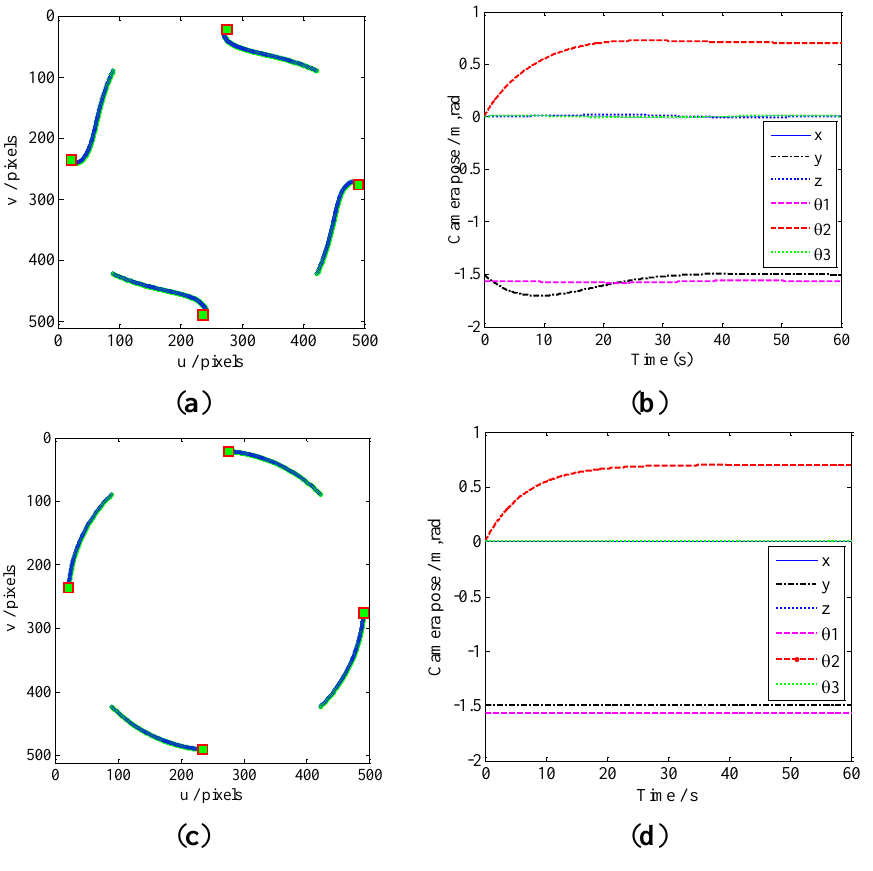
Figure 8. Comparison of our method with the PBVS method for Case 2. The feature trajectories are constrained on the FOV by our method, while the results of PBVS almost leave the FOV. ( a ) Feature trajectories by our method; ( b ) The camera pose by our method; ( c ) Feature trajectories by PBVS; ( d ) The camera pose by